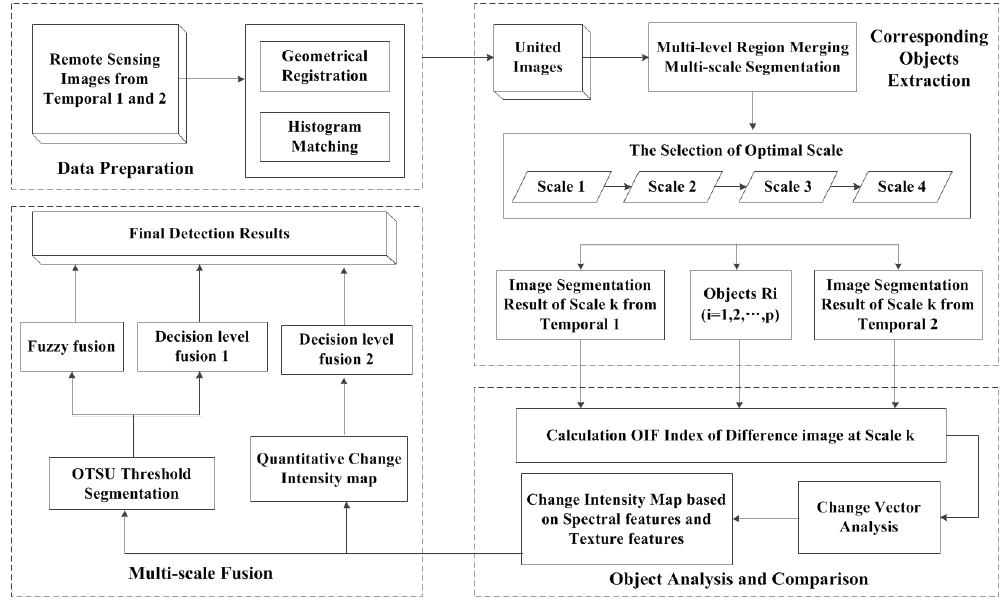
Figure.1 Framework of the proposed